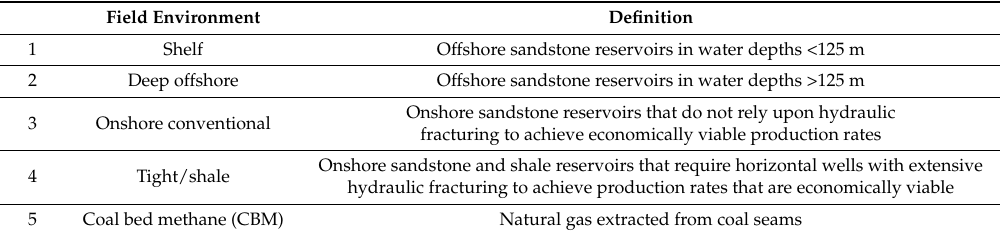
Table 1. Definitions of field